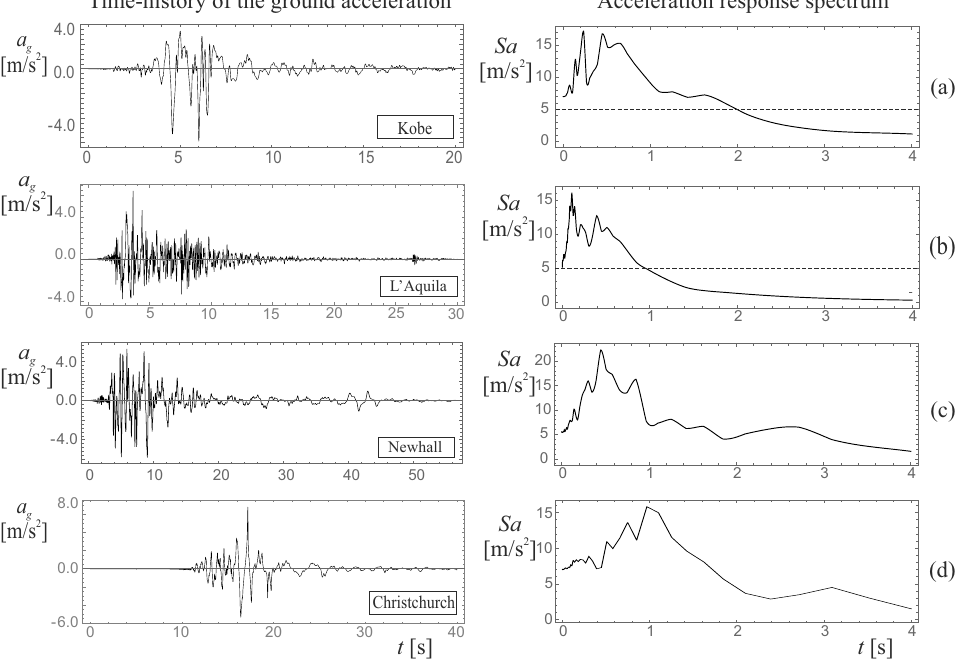
Figure 7. Time histories and pseudo-acceleration spectra of the earthquakes analysed: ( a ) Kobe; ( b ) L’Aquila; ( c ) Newall; ( d )